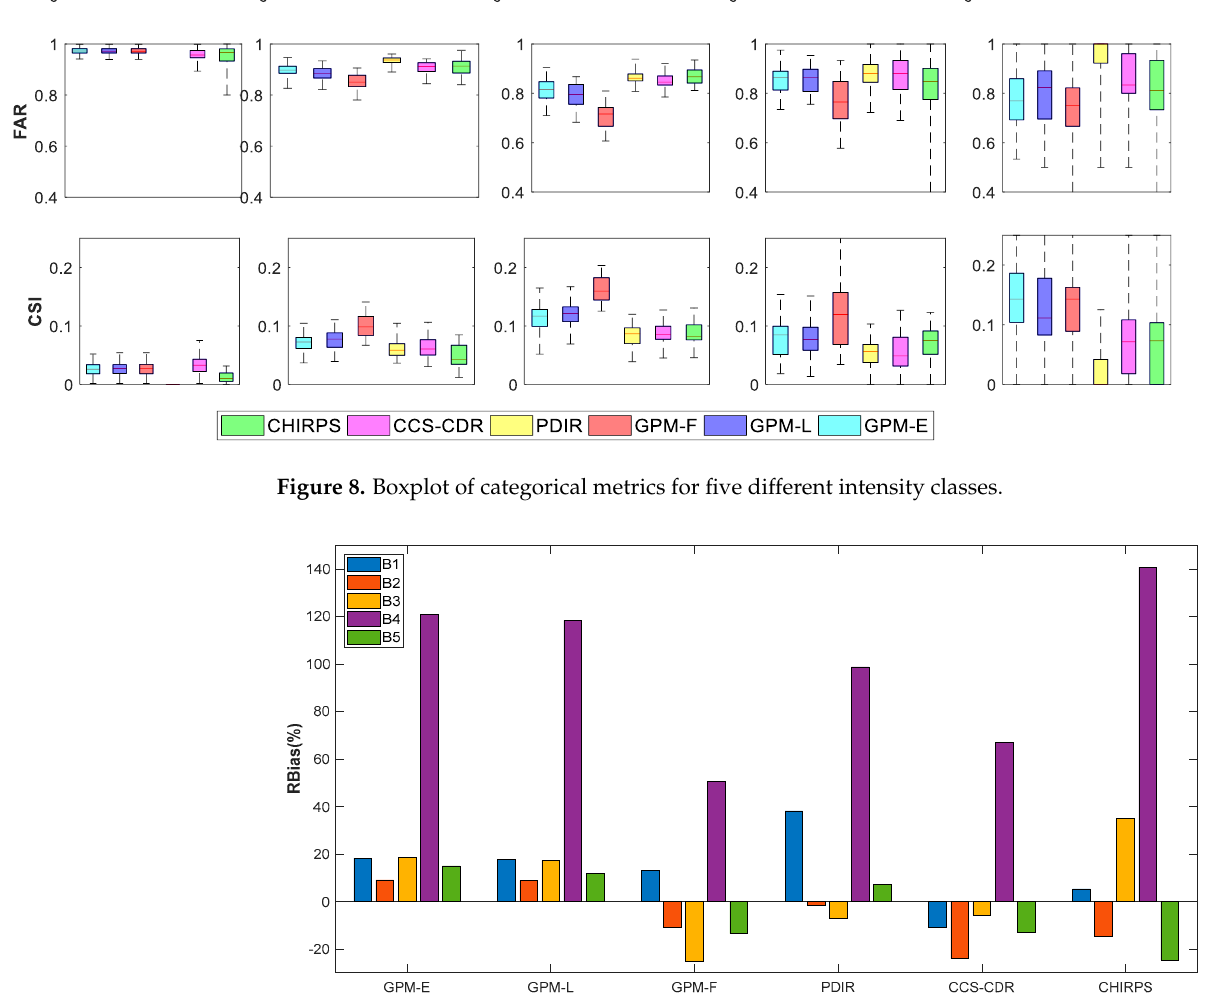
Figure 8. Boxplot of categorical metrics for five different intensity classes.